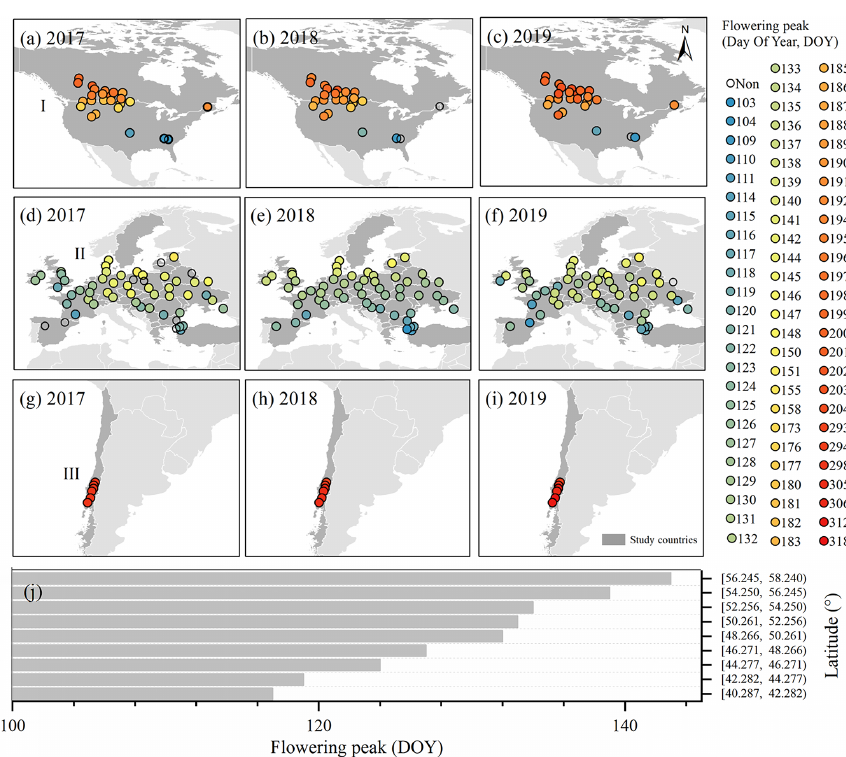
Figure 3. The spatial distribution of rapeseed flowering dates. (a) – (i) Flowering dates (Julian day) in different sample blocks in 2017, 2018, and 2019. (j) Characteristics of the latitudinal gradient in Europe. The peak flowering date for each latitudinal interval is the mean of the flowering dates of all sample blocks within that interval.